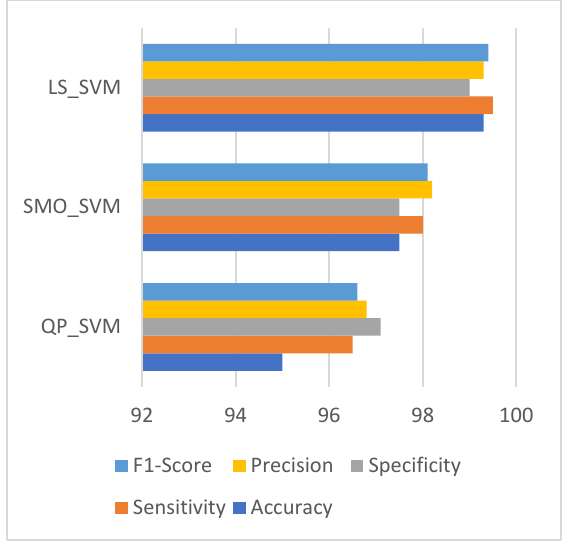
Figure 11. Performance of Different SVM types for Hybrid features. Finally, we compared our proposed algorithms with other recent works in the literature Table 6. Comparison between DNN and SVM for hybrid features and WTSST-DCNN. that used the same Bern-Barcelona database, as shown in Table 7. From the table, the proposed algorithms in this work showed improvements in performance as compared with some recent work that experimented with the same dataset. Bhattacharyya et al. [12] used reconstructed phase space (RPS), EWT, and LS_SVM to characterize focal and non-focal EEG signals and obtained an accuracy of 90%. Acharya et al. [51] employed nonlinear features and reported an accuracy of 87.93%. Details of comparison can be found in Figure 7 and Section 5.3. Table 7. Comparison of recent works that used the same database with our work and our proposed method.